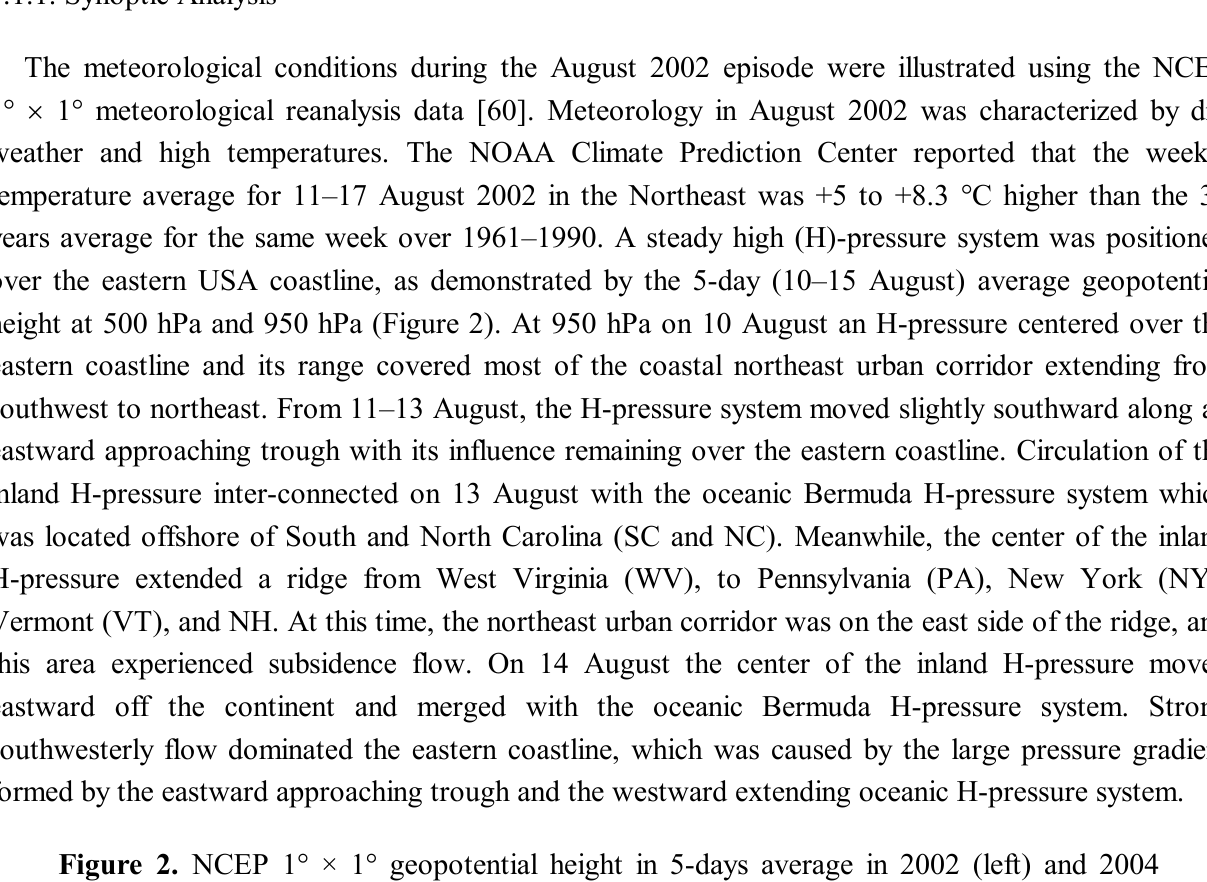
Figure 2. NCEP 1° × 1° geopotential height in 5-days average in 2002 (left) and 2004 (right) at 500 hPa (top) and 950 hPa (bottom). Shaded interval is 10